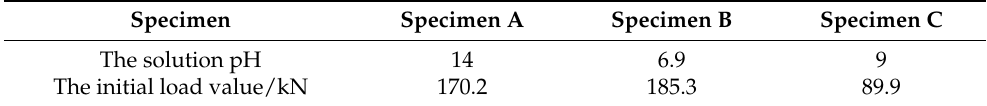
Table 2. Specifications of each specimen.